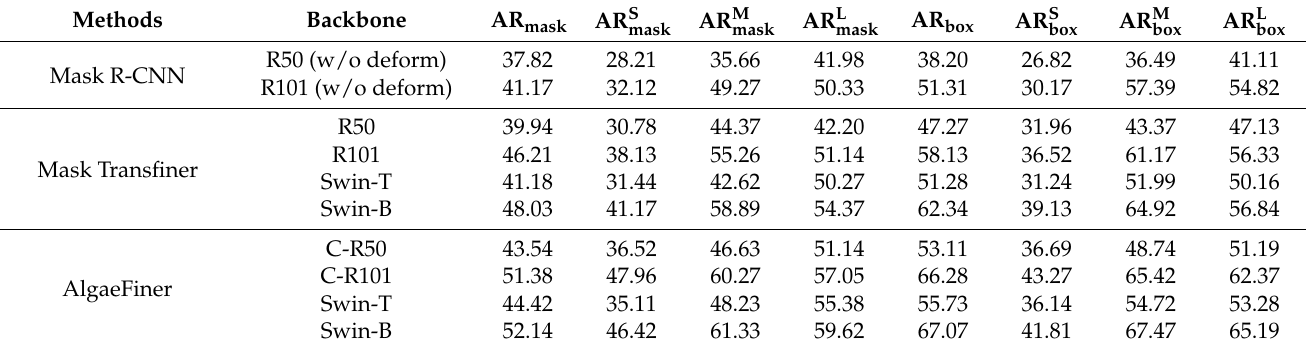
Table 5. Comparison performance of different models on AR.